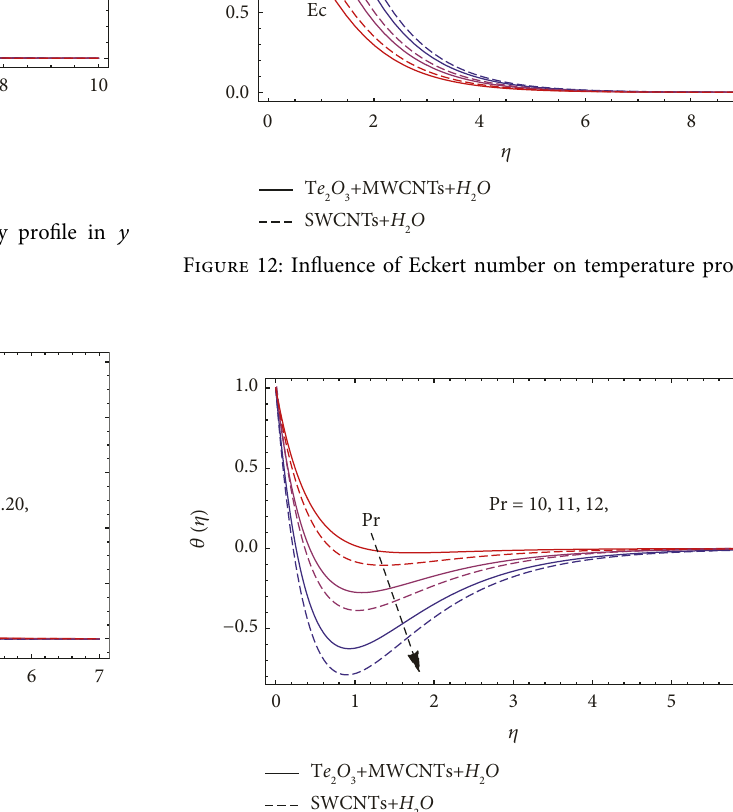
Figure 10: Influence of nanoparticle volume frication on velocity profile in y direction.